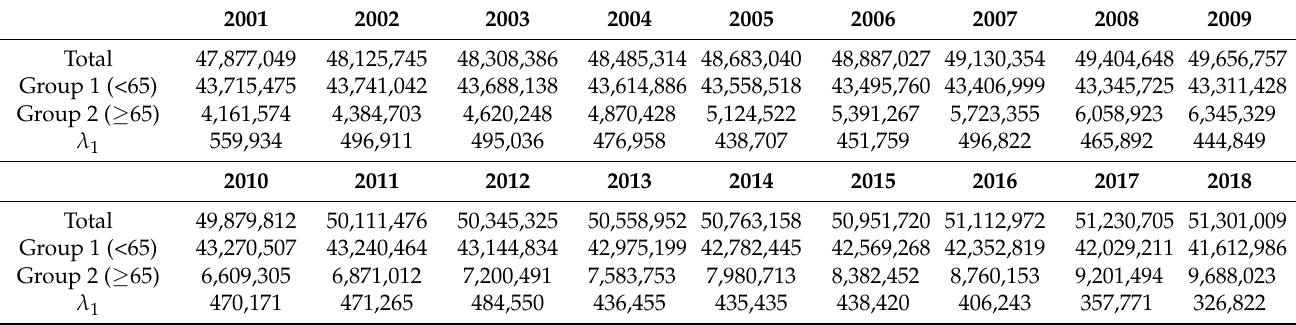
Table 1. Age-specific population size is shown [20]. Note that the elderly age group ( ≥ 65 years) is rapidly increasing while the number of newborn population is decreasing ( λ 1